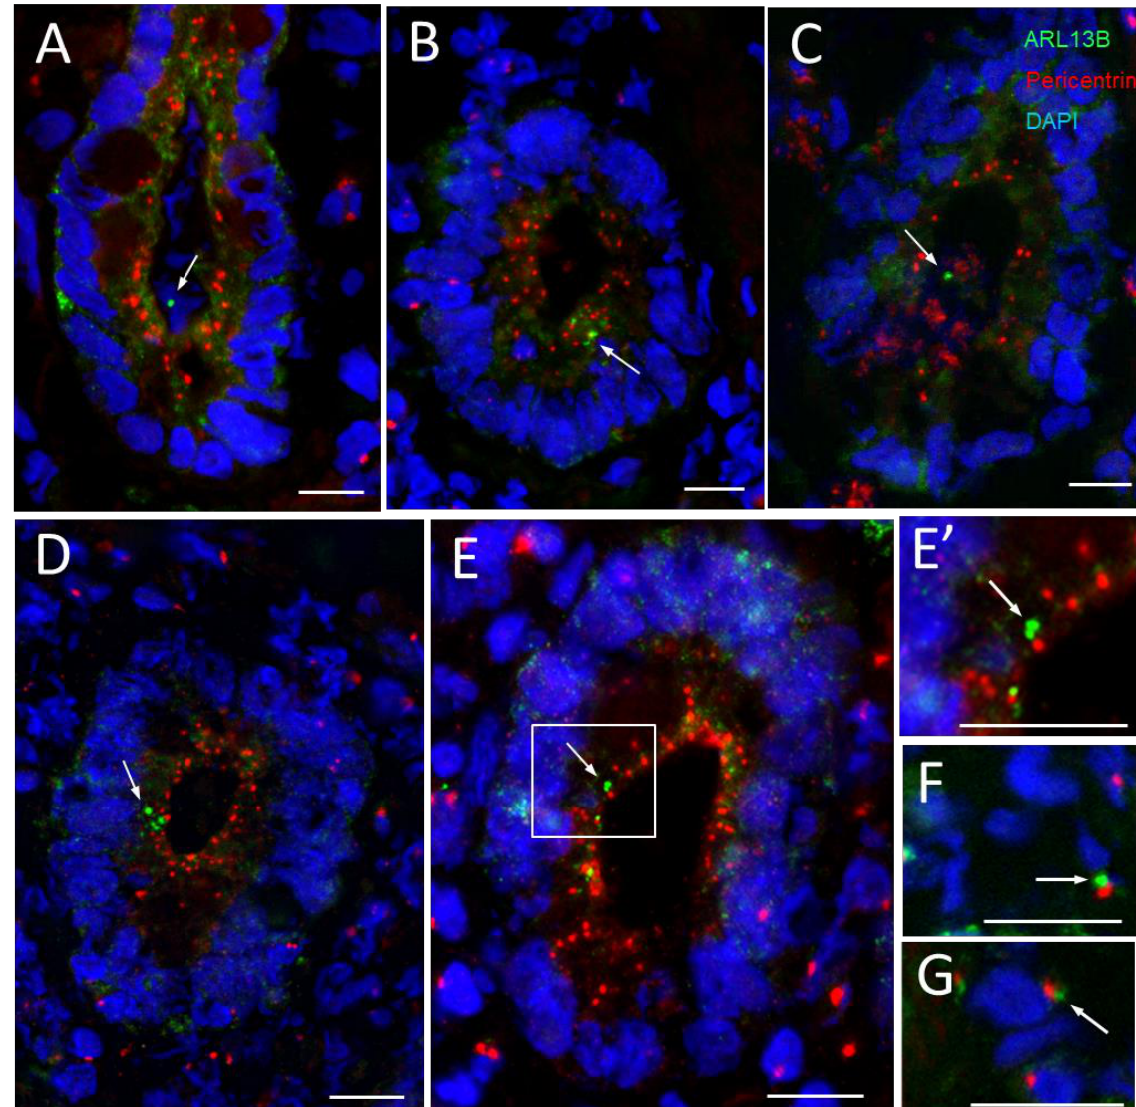
Figure 6. Primary cilia and centrosomes in the lower third of the crypts of the human small intestine. ( A – E ) Representative immunodetection of primary cilia using the anti-ARL13b 90413h antibody (green staining, arrow) and of centrosomes using an anti-pericentrin antibody (red staining) in various crypts. In most cases of positive crypts, the 90413h antibody stained one predominant dot ( A – E ) that was localized adjacent to a positive pericentrin-labeled dot, as in ( B – E ). ( E ’ ) Higher magnification of the section delimited by the square in ( E ) showing adjacent dots stained by ARL13B and pericentrin. ( F , G ) are high magnifications of the stroma around the crypts showing a similar distribution of ARL13B and pericentrin in ciliated fibroblasts. Nuclei were stained with DAPI (blue staining). Scale bars are equal to 10 µm.